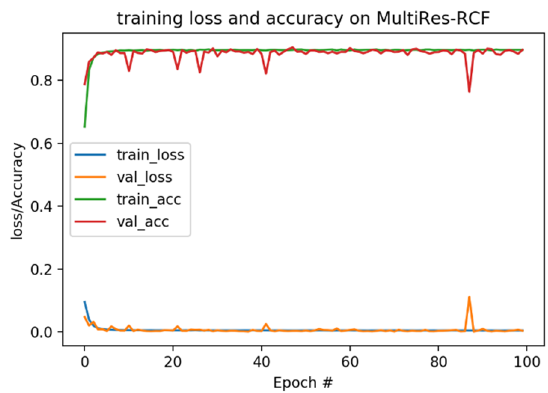
Figure 5. Loss and accuracy of Multi-RCF during training process.